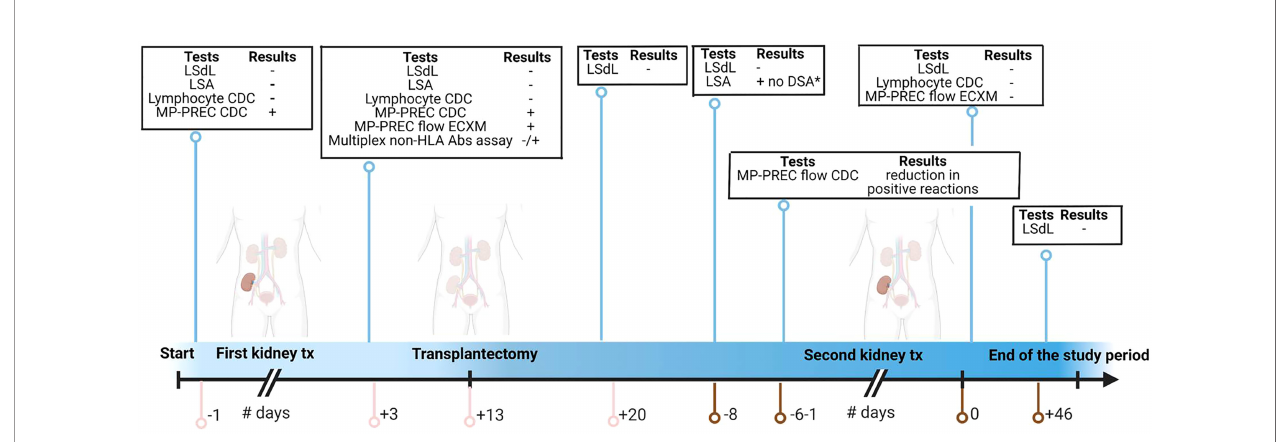
FIGURE 1 | Timepoints for samples obtained and tests performed. The pink line represents the days related to the fi rst kidney transplantation; the brown line represents the days related to the second kidney transplantation. tx, transplantation; LSdL, Life Screen Deluxe; LSA, Luminex single-antigen bead assay; CDC, complement-dependent cytotoxicity; MP-PREC, machine perfusion derived primary renal endothelial cells; ECXM, endothelial cell crossmatch; DSA, donor-speci fi c antibodies Figure created with